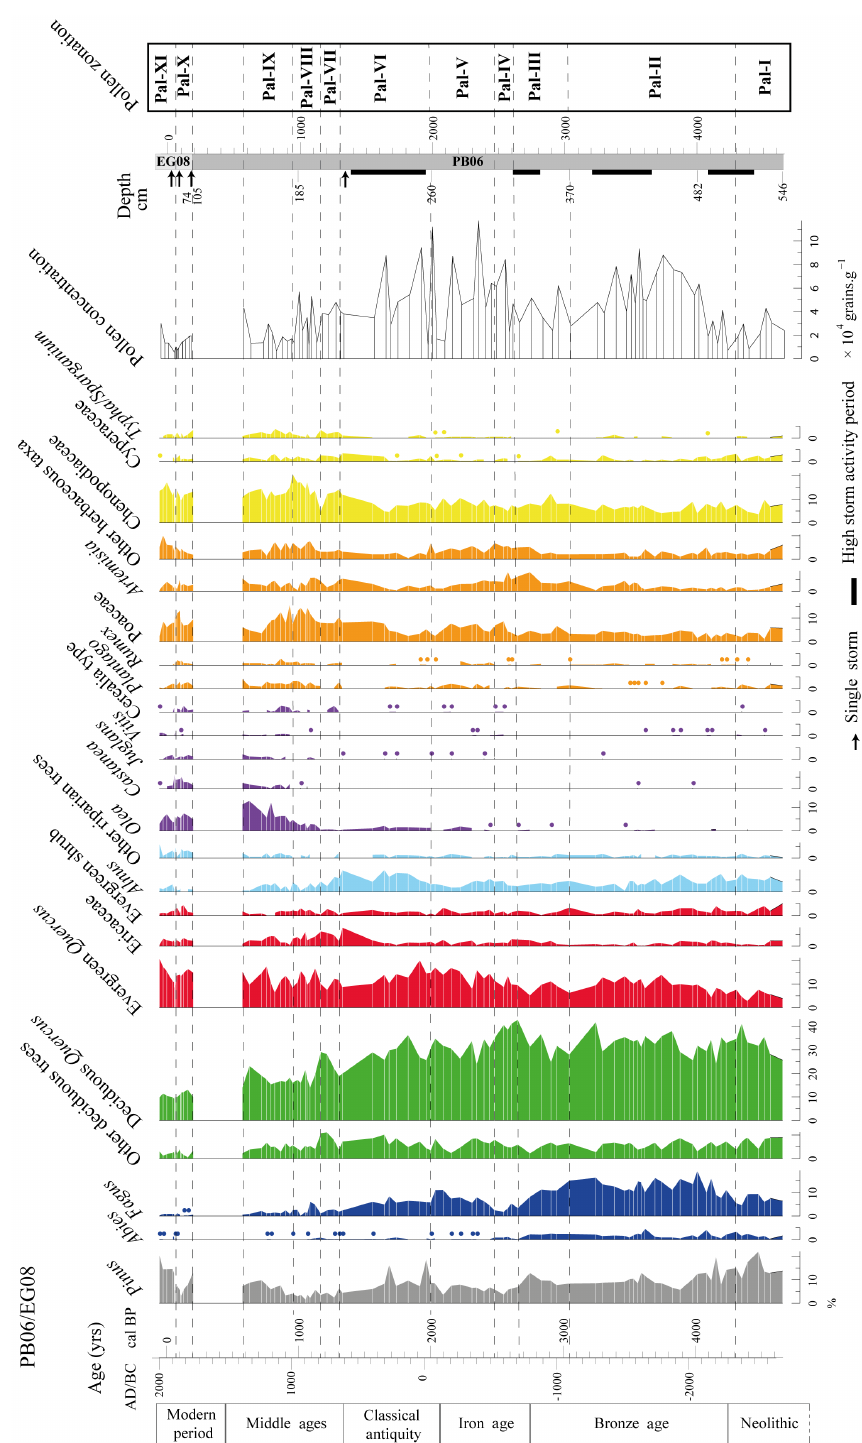
Figure 2. Pollen diagram of the cores PB06 and EG08. Pollen curves are presented in calendar yearBP (correspondence between age and depth is presented on the left). The pollen zones are represented on the right of the